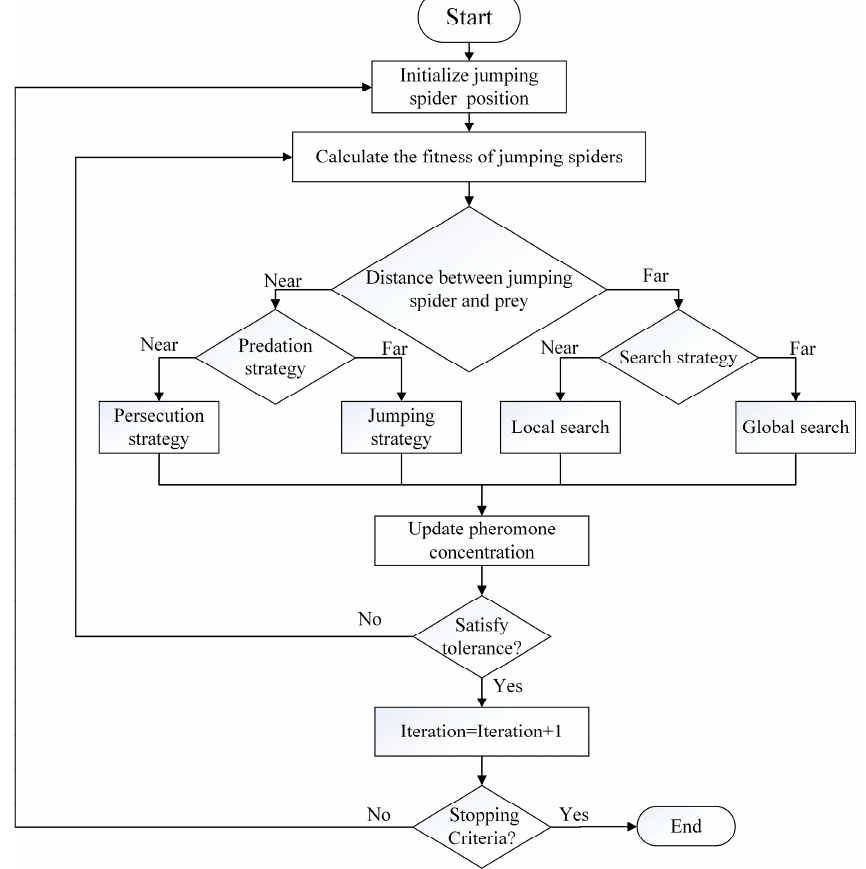
Figure 4. IJSOA flowchart.